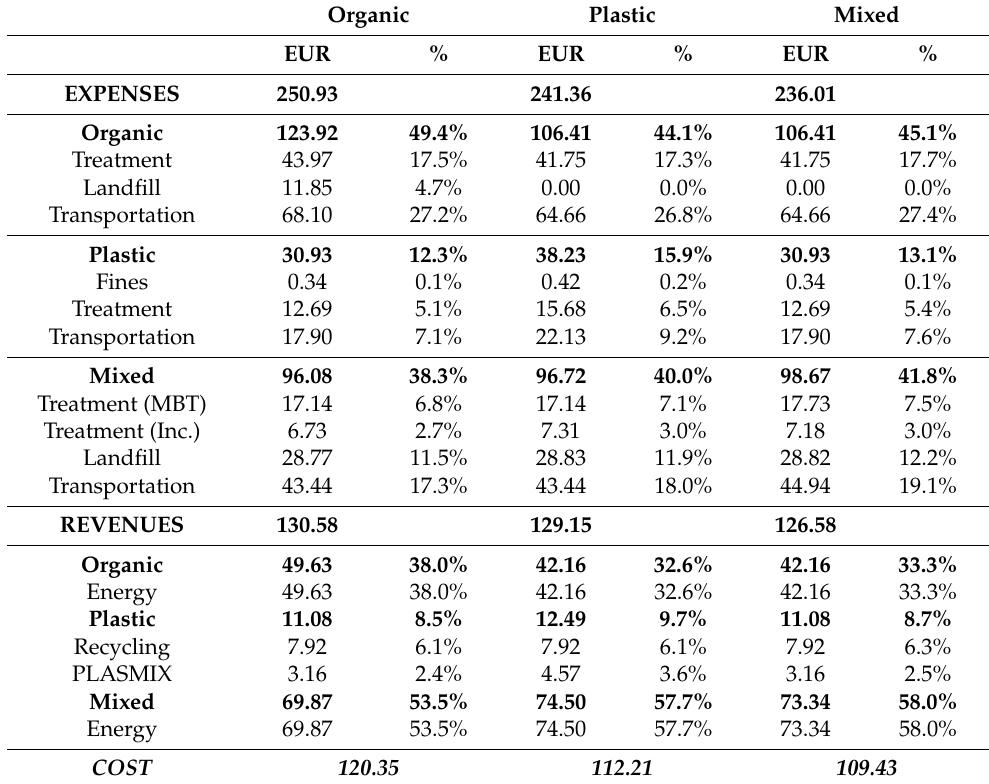
Table 3. Waste management system expenses, revenues and costs of the organic, plastic and mixed waste treatment routes’ values and contribution